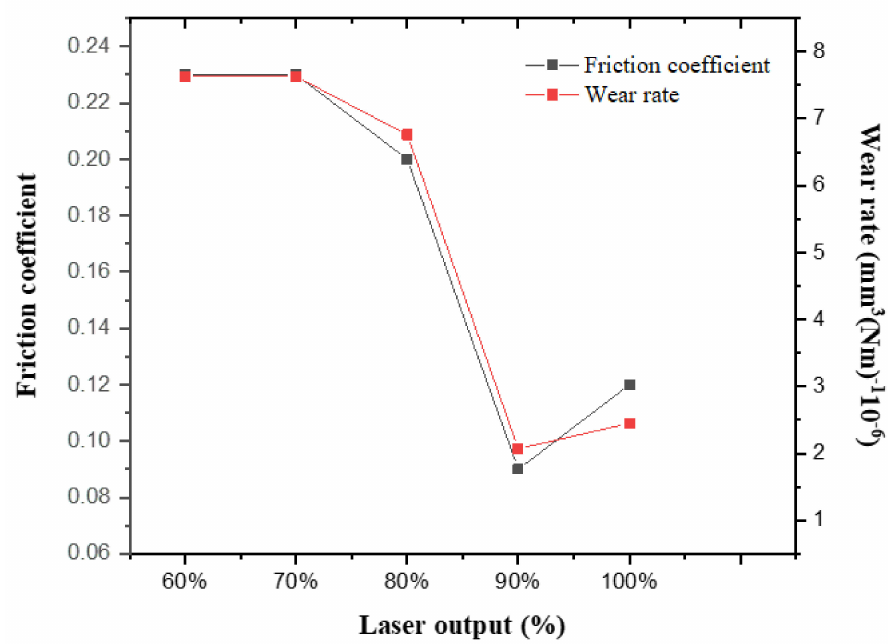
Figure 6. Friction coefficient and wear rate of as-deposited SUS304 and carbon-doped SUS304 by laser